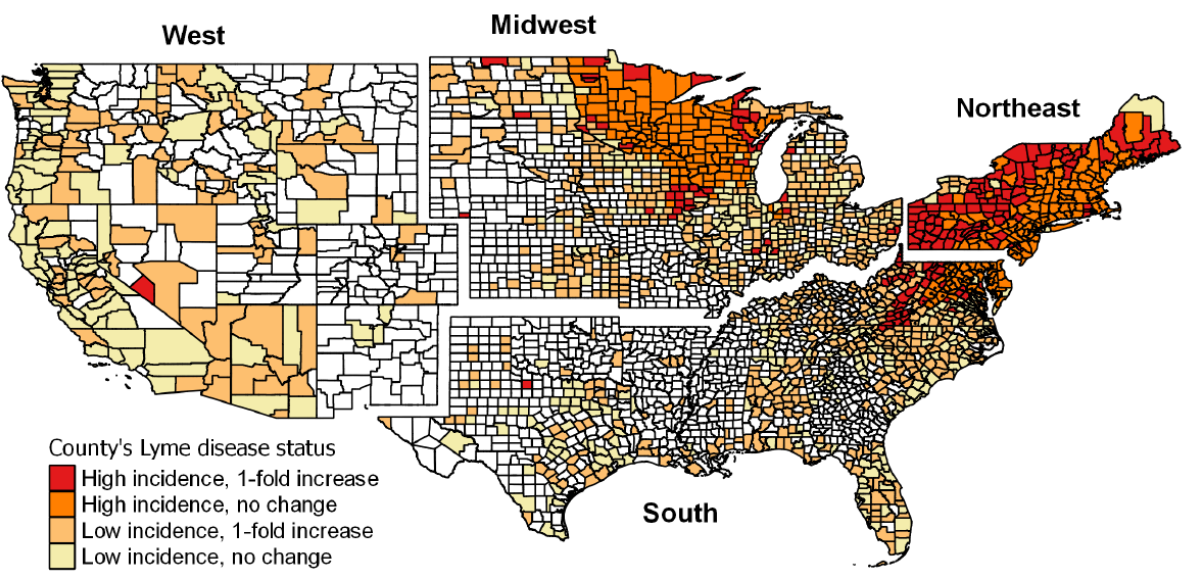
Figure 4. County’s Lyme disease status according to Lyme disease incidence and recent increase in